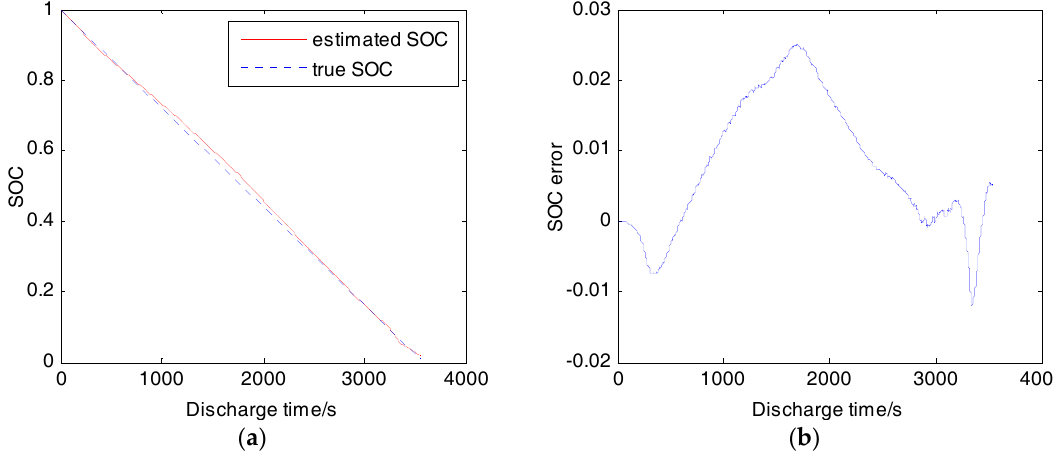
Figure 11. SOC estimation result (25 °C, 1 C): ( a ) Estimated SOC and true SOC; ( b ) SOC estimation error.